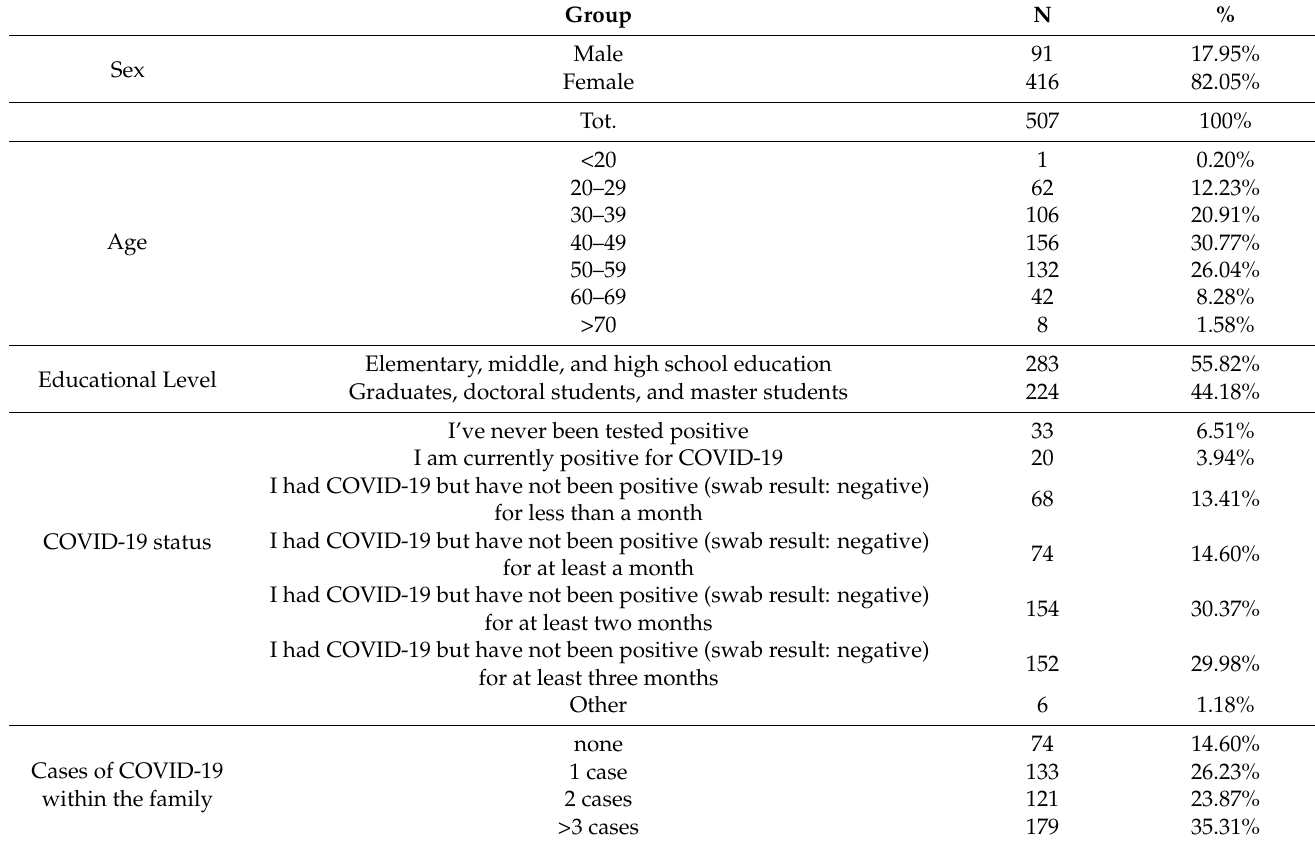
Table 1. Demographic